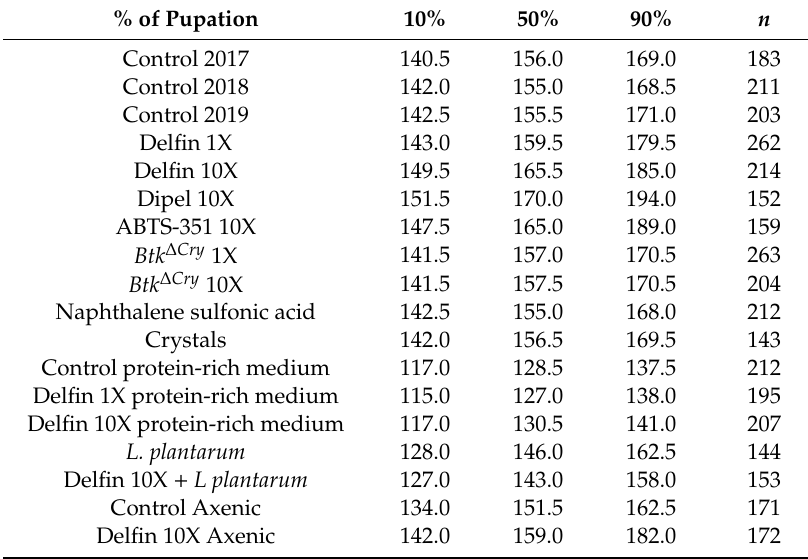
Table 1. Time in hours when 10%, 50%, and 90% larvae enter the pupation stage (immobilized) expressed in hours after egg laying. “n” corresponds to the number of larvae counted in each condition. Please note that we compiled the controls per year of experiments (encompassing years from 2017 to